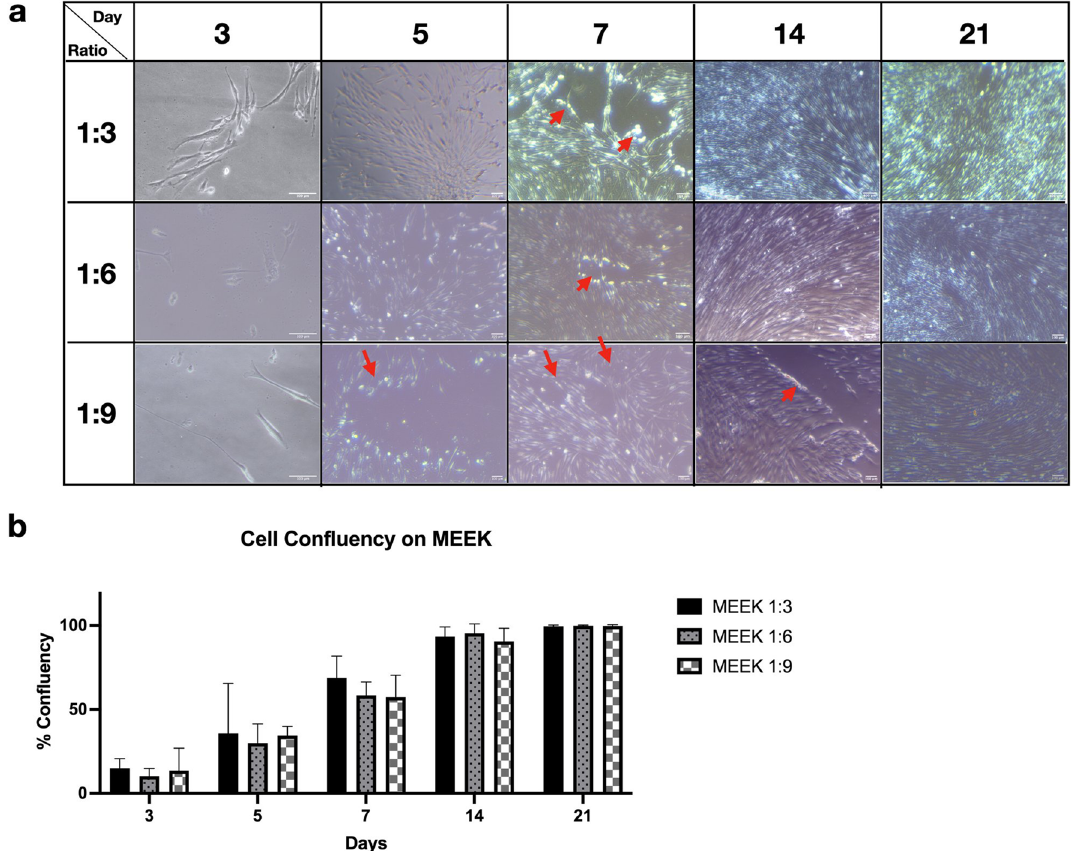
Figure 4. Reattachment of fibroblast cells from MEEK gauze to new culture dishes. ( a ) The presence of fibroblast cells from MEEK gauzes at 1:3, 1:6 and 1:9 expansion ratios was observed at days 3, 5, 7, 14 and 21 under a phase contrast microscope. The red arrows indicate the edges of the cell sheet islands. ( b ) The confluency of fibroblasts on new surfaces at various time points was determined. The results are displayed as the mean ± SD (n = 6). Statistically significant differences were defined using one-way ANOVA with Tukey’s multiple comparison test. The scale bars represent 100